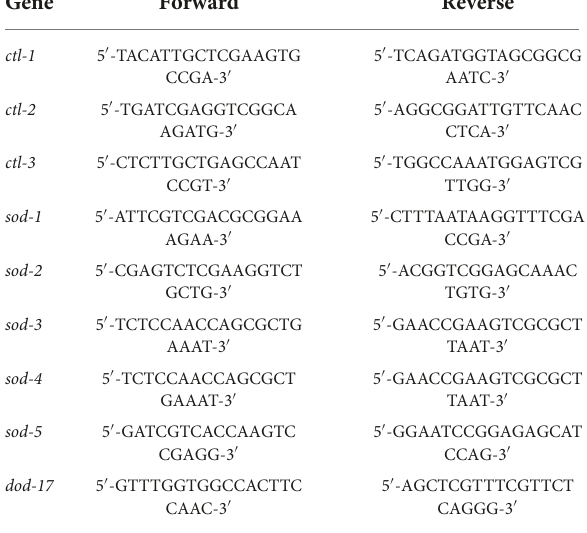
Figure 1B . Mean lifespan values were calculated by a log-rank test. P -values were calculated for individual experiments and each consisting of control and treatment